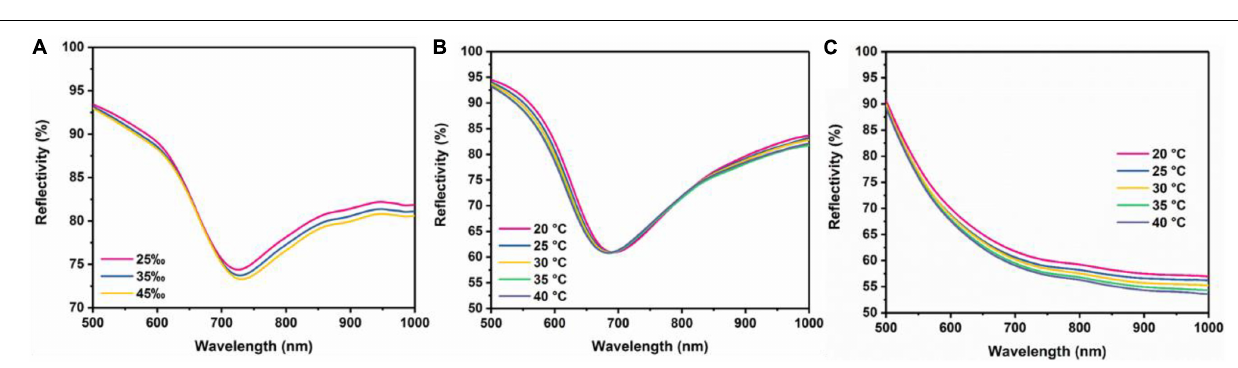
concentration in most marine environments combined with high electrical conductivity makes marine bodies a highly conducive environment for corrosion to occur on metal surfaces, including